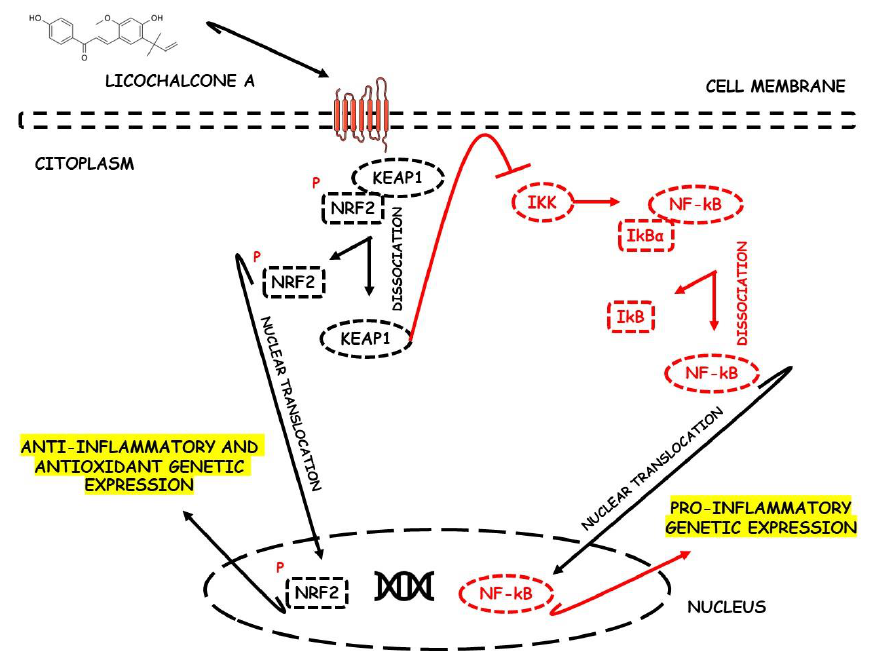
Figure 2. Possible therapeutic targets for chalcones against the IBD-related NF-kB and Nrf2 dysregulation. IkB, inhibitor of nuclear factor-kB; IkB α , nuclear factor of kappa light polypeptide gene enhancer in B-cells inhibitor, alpha; IKK, inhibitor of nuclear factor- κ B (I κ B) kinase; KEAP1, Kelch-like ECH-associated protein 1; NF-kB, nuclear factor kappa b; Nrf2, nuclear factor erythroid 2–related factor